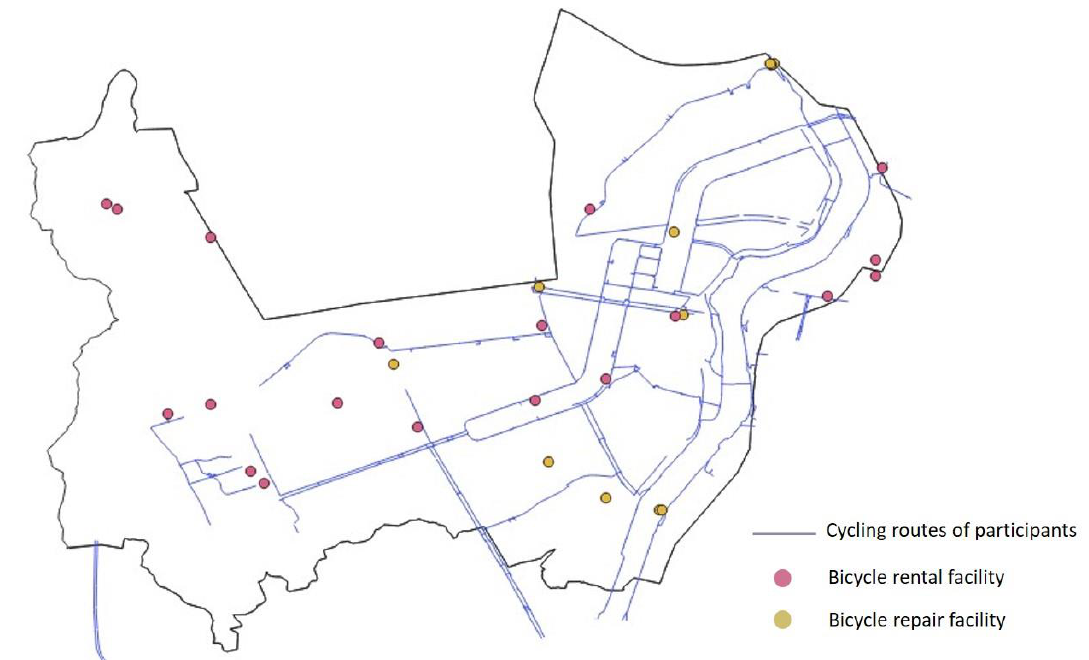
Figure 2. Spatial pattern of cycling behaviors and infrastructure.